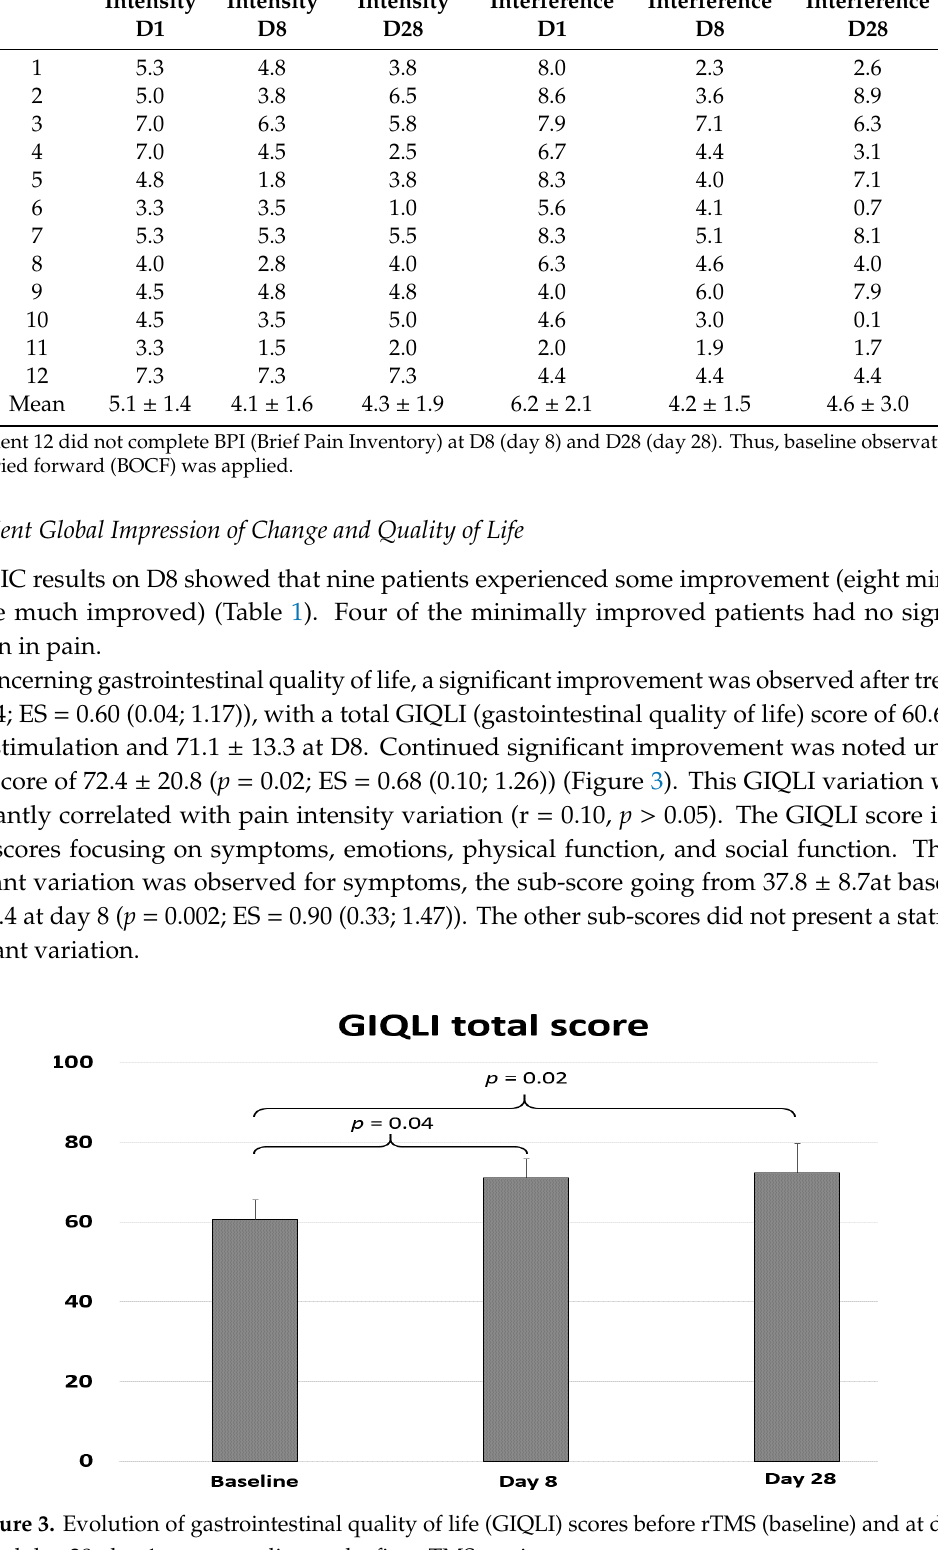
Table 2. Brief pain inventory (pain intensity and pain interference) at day 1, day 8 and day 28. Mean values are noted using bold characters.